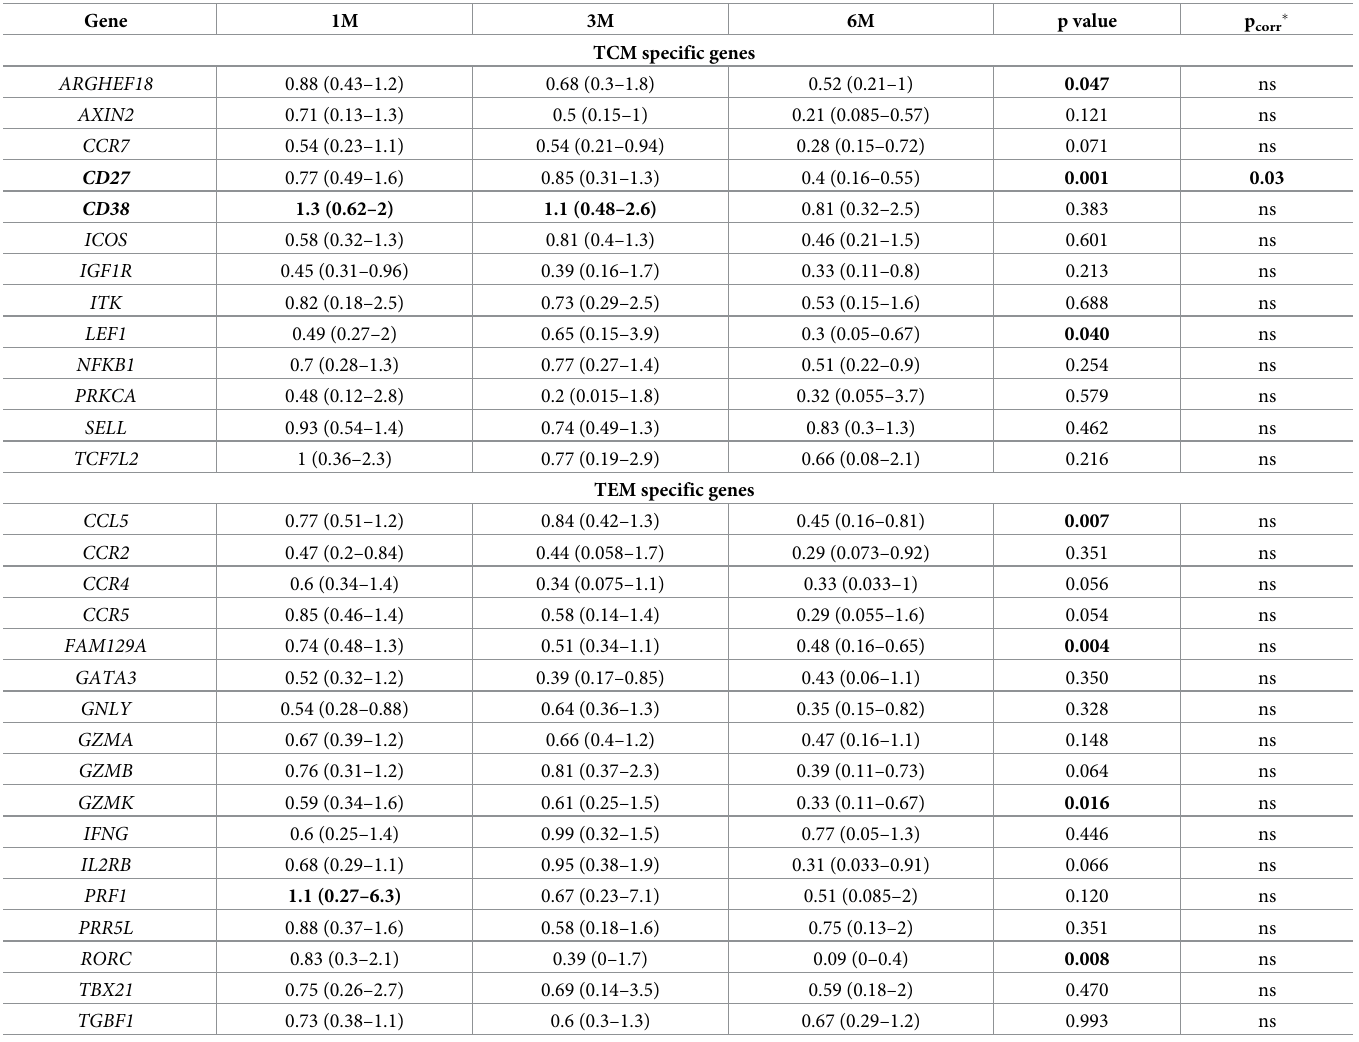
Table 3. Fold change (median and IQR) of gene expression between day 0 and 1M, 3M, 6M of ART, with correction for increasing CD4 counts. Increased gene expression is indicated by values > 1. p-values listed compare gene expression between day 0 and 6 months of ART, as well as after Bonferroni correction for multiple com- parisons (p corr �